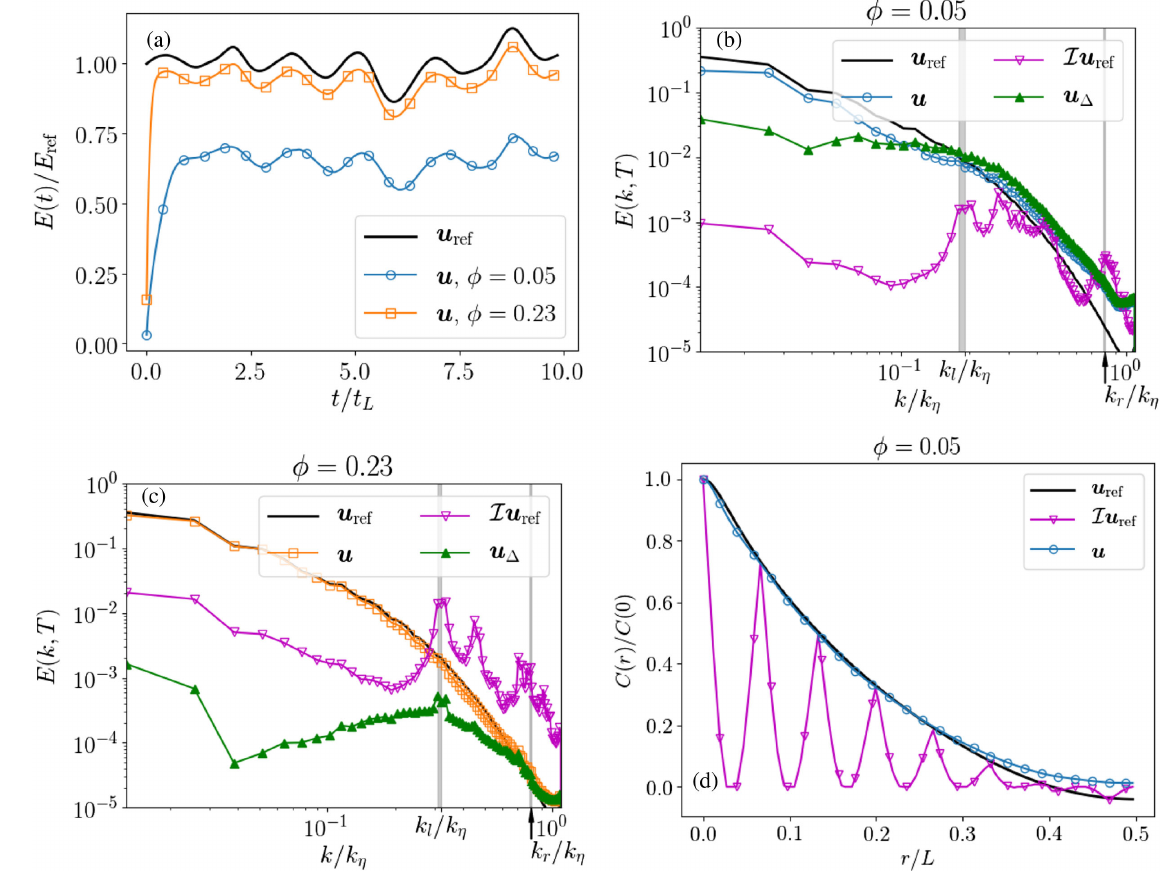
FIG. 3. (a) Evolution of the total energy for the reference field and for two nudged fields with different volume fraction, before and close to full synchronization, ϕ ¼ 0 . 05 , 0.23. (b) Log-log plots of the energy spectra for the reference field (the truth) u partial data I u , the nudged field on the whole volume u , and the spectrum of the error field u Δ at the end of the simulation for the ref simulation with ϕ ¼ 0 . 05 . (c) Same as (b) for the simulation with ϕ ¼ 0 . 23 . Gray regions mark the two typical wave numbers k l and k r (see text). Note the transition to full synchronization for (c), where the spectrum of the error field u Δ is negligible at all scales. (d) Two- point correlation functions for the case with ϕ ¼ 0 . 05